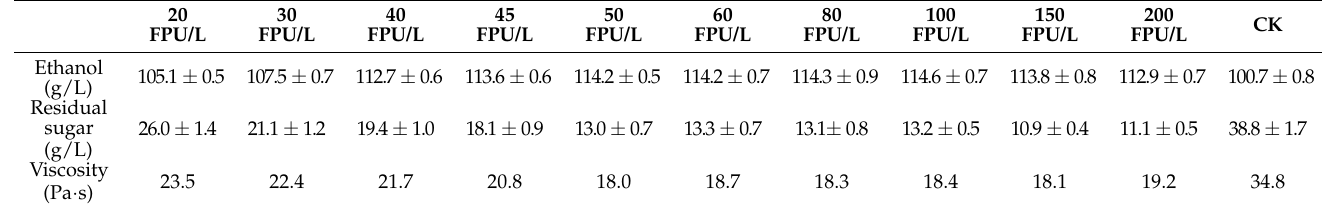
Table 1. Comparison of ethanol, reducing sugars, and viscosity at different enzyme